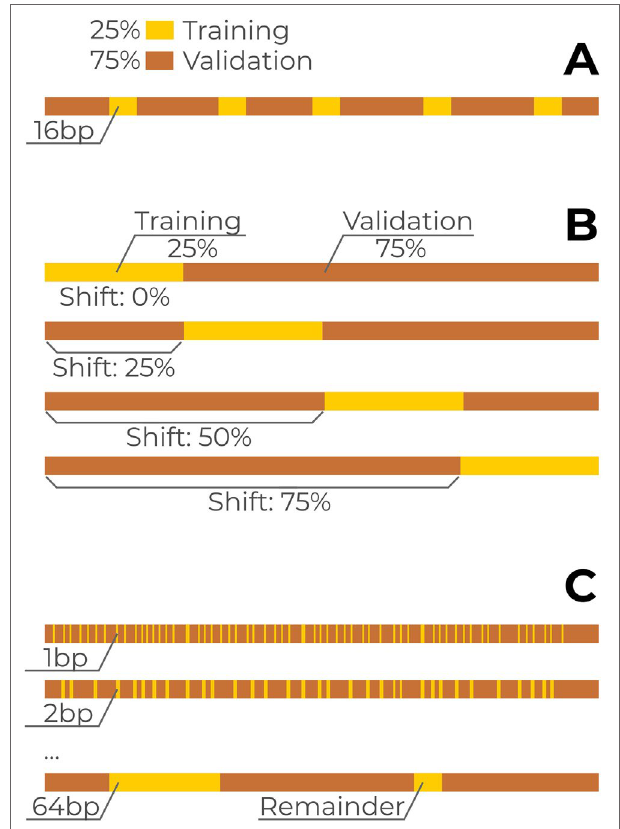
fiGURe 1 | Data separation into training and validation subsets. A single reporter is shown, the scheme was identical for all reporters. Yellow bars: training subset, brown bars: validation subset. (A) Original CAGI setup. For each reporter, the training subset of single-nucleotide variants (SNVs) (25% from total) consists of multiple 16bp blocks spanning over neighboring reporter coordinates. (B) Continuous blocks covering 25% of reporter length for each reporter with a varying shift from the reporter 5’ end. (C) Training data with varying block lengths from 1 to